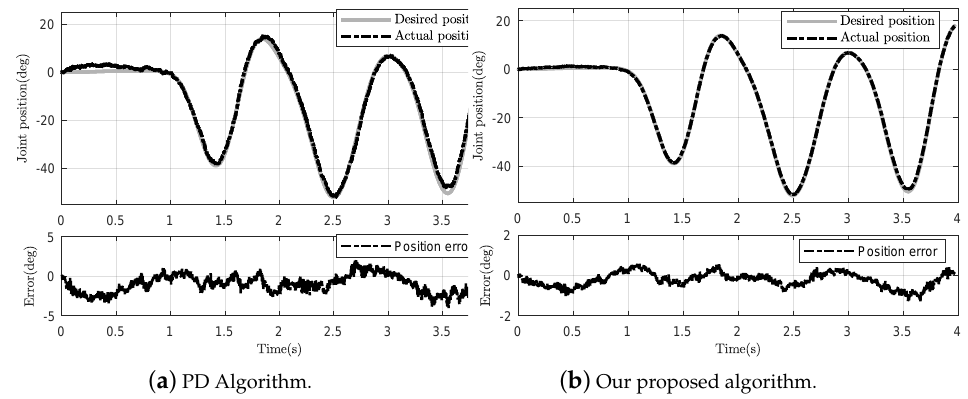
Figure 14. Comparison of the PD control method and our proposed algorithm with the same planning trajectory without human